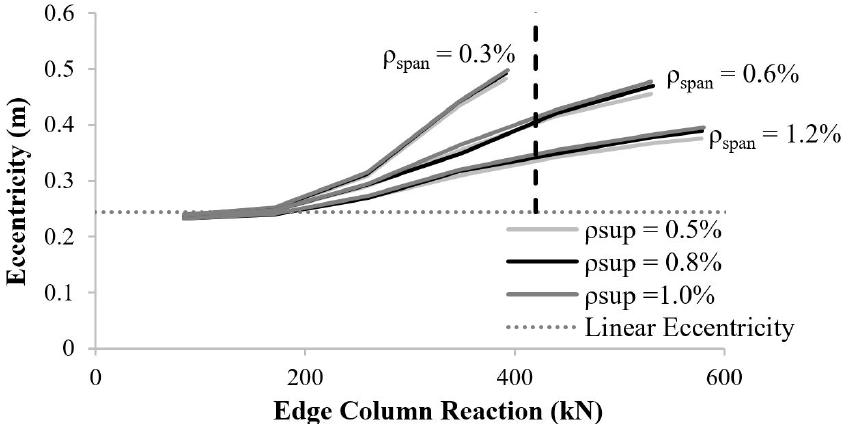
Figure 12. Influence of varying reinforcement arrangement in the eccentricity of the subassembly’s edge